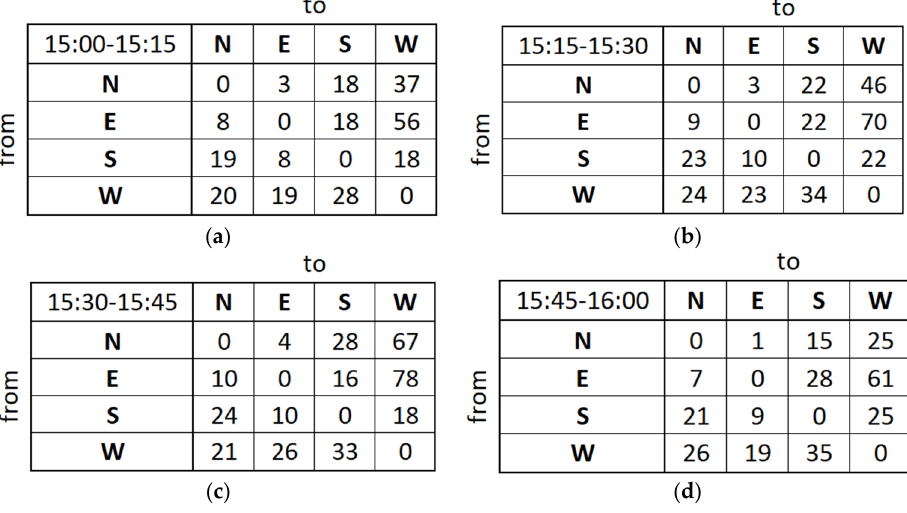
Figure 4. Traffic volume matrices entered into the intersection model at 15-min intervals in the afternoon peak hour. ( a – d ) contain volumes aggregated to each interval, captioned in the first cell of every matrix.